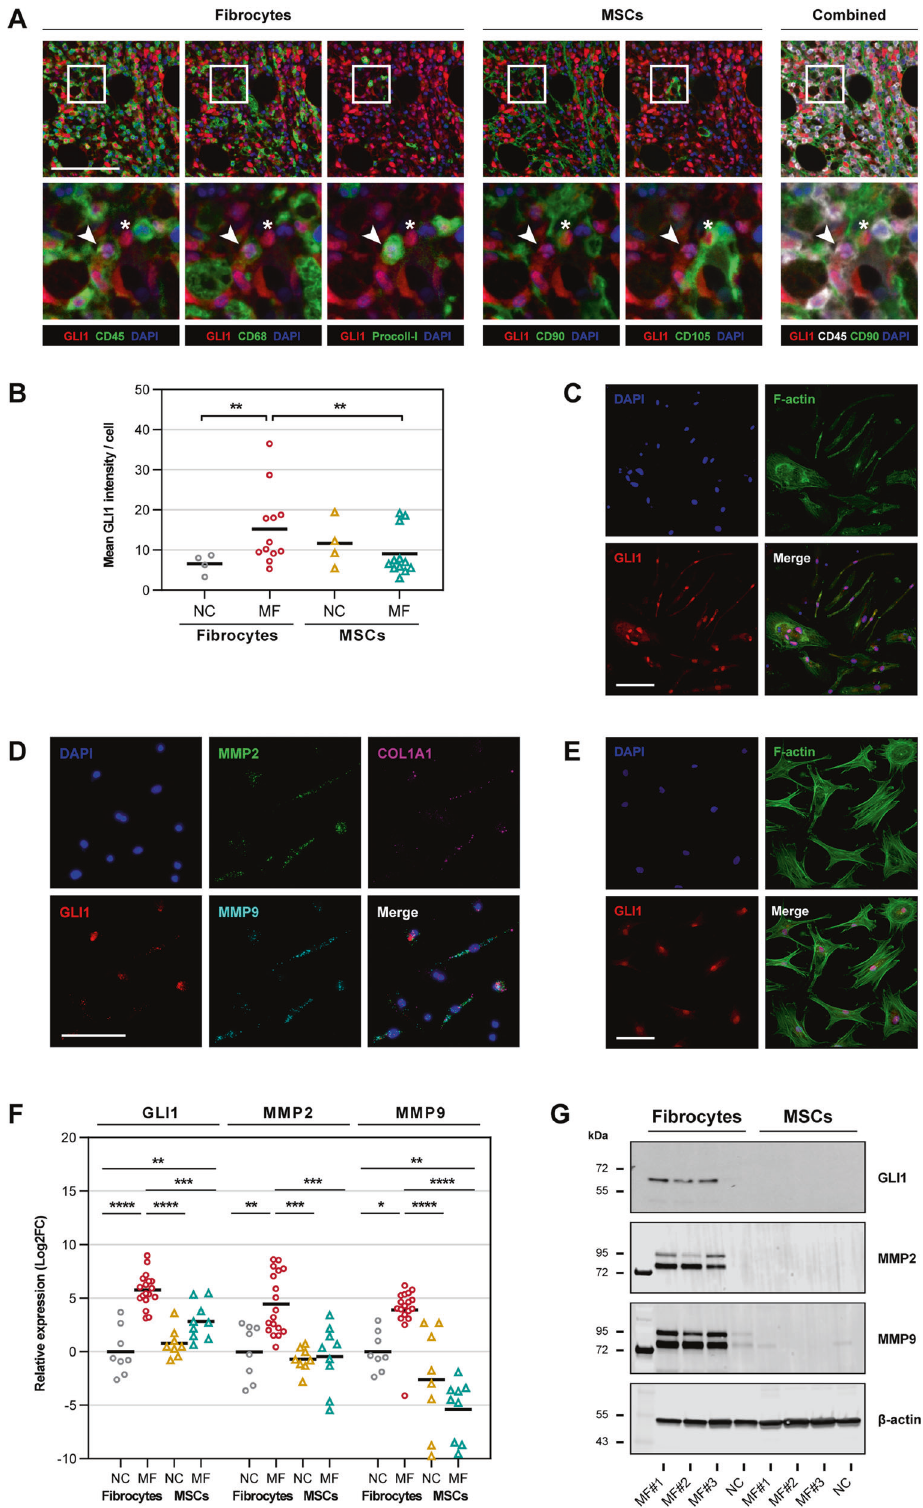
BM fi brocytes than in MSCs and that MF patients ’ fi brocytes had signi fi cantly higher GLI1 signal intensity levels compared to BM fi brocytes of healthy individuals ( P < 0.01 in both). Conversely, GLI1 intensity levels in BM MSCs of MF patients were similar to those of BM MSCs of healthy individuals (Fig. 1B).